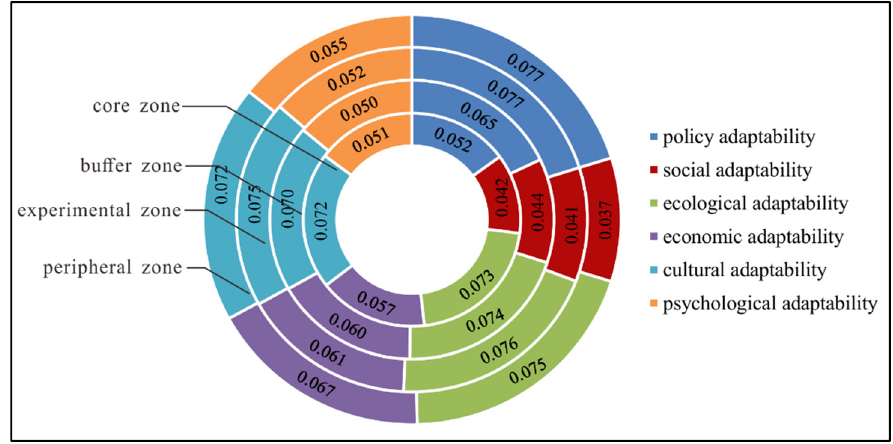
Figure 5. The adaptability of different regions in different dimensions.